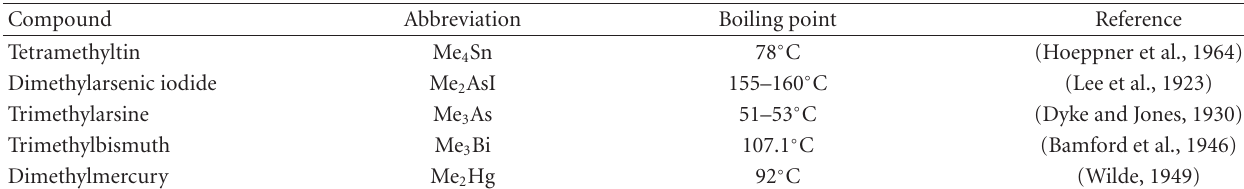
Table 1: Boiling points of volatile metal(loid) species.